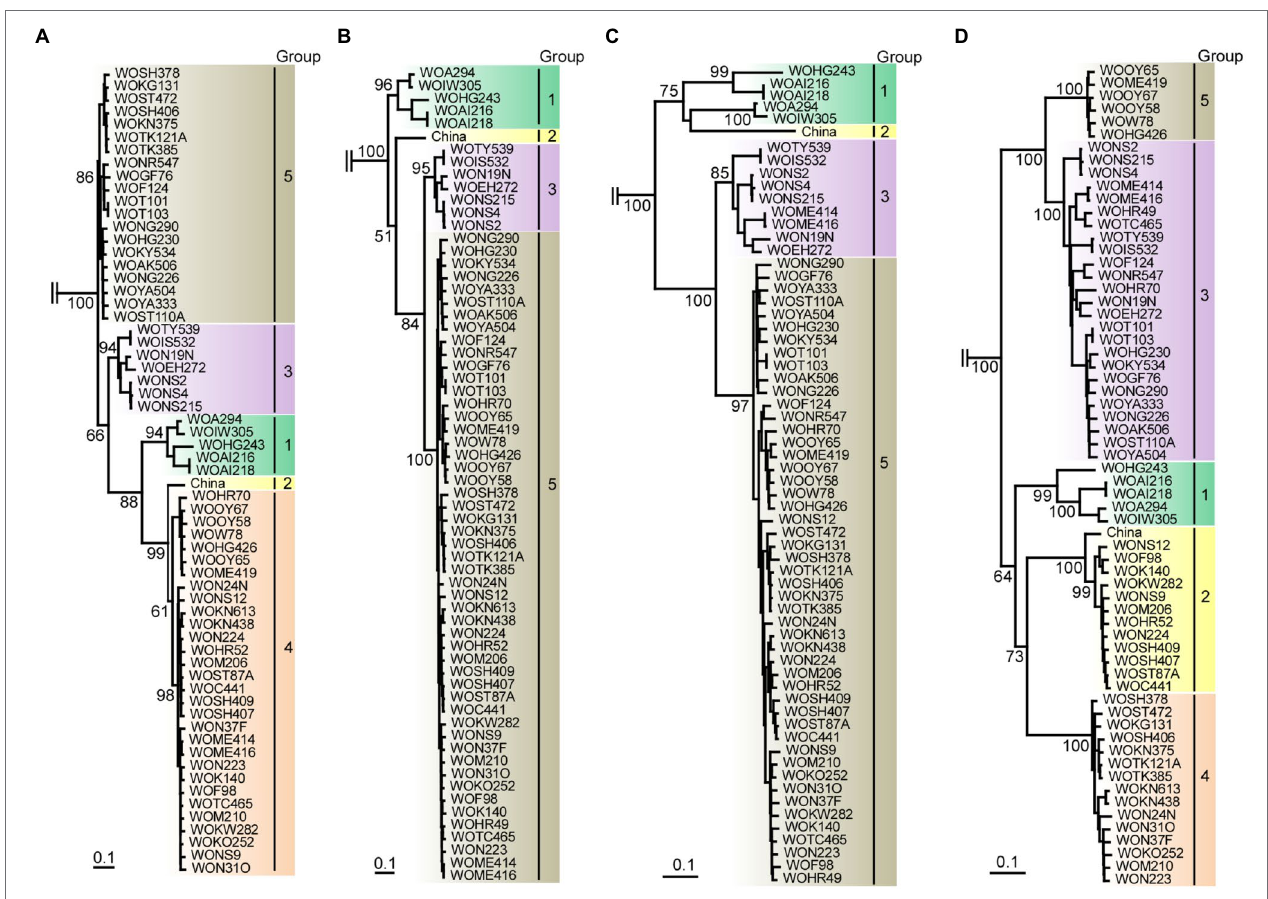
FIGURE 5 | Maximum-likelihood tree showing the relationships of the four partial genomic sequences of scallion mosaic virus (ScaMV) isolates and the viruses in TuMV phylogenetic group. For partial genomic regions, (A) nt 110–965, (B) nt 1,520–3,098, (C) nt 3,610–4,523, and (D) nt 5,762–9,112 were used to construct trees after removing gaps from aligned sequences. Three homologous sequences of JYMV (Fuji and Nakamae, 1999, 2000; Lan et al., 2015), two TuMV (Nguyen et al., 2013), three NLSYV and three NYSV (Chen et al., 2006; Lin et al., 2012; Wylie et al., 2014; Ohshima et al., 2018), and one WoSV (Ohshima et al., 2016a) were used as outgroup taxa; however, those are not shown. Numbers at each node indicate bootstrap percentages based on 1,000 pseudoreplicates. (Only percentages greater than and equal to 50 are shown.) Horizontal branch lengths are drawn to scale with the bar indicating 0.1 nt substitution per site. The inferred trees were displayed by TreeView (Page,